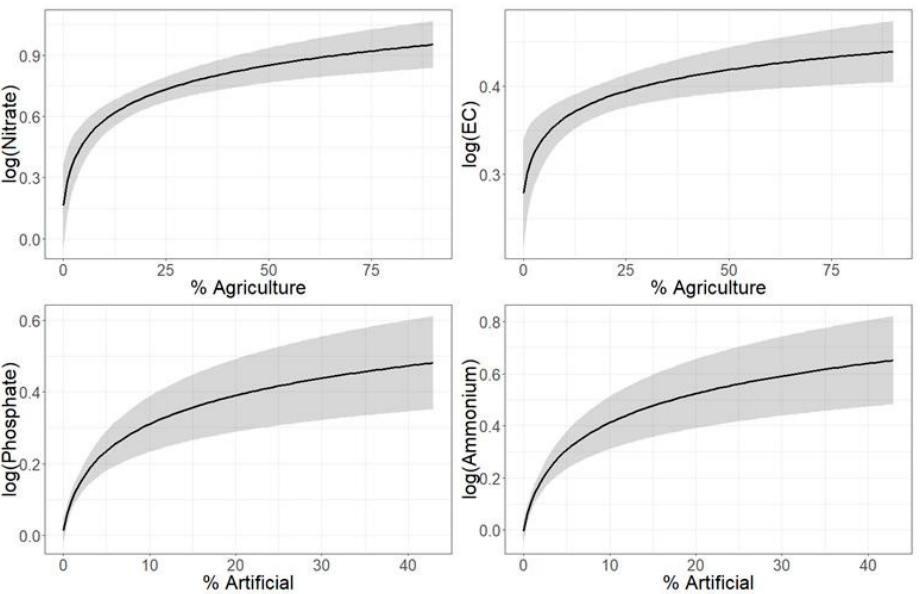
Figure 11. Predicted values of the nitrate ( top left ) and EC ( top right ) to Agricultural land use, and phosphate ( bottom left ) and ammonium ( bottom right ) to Artificial land use.